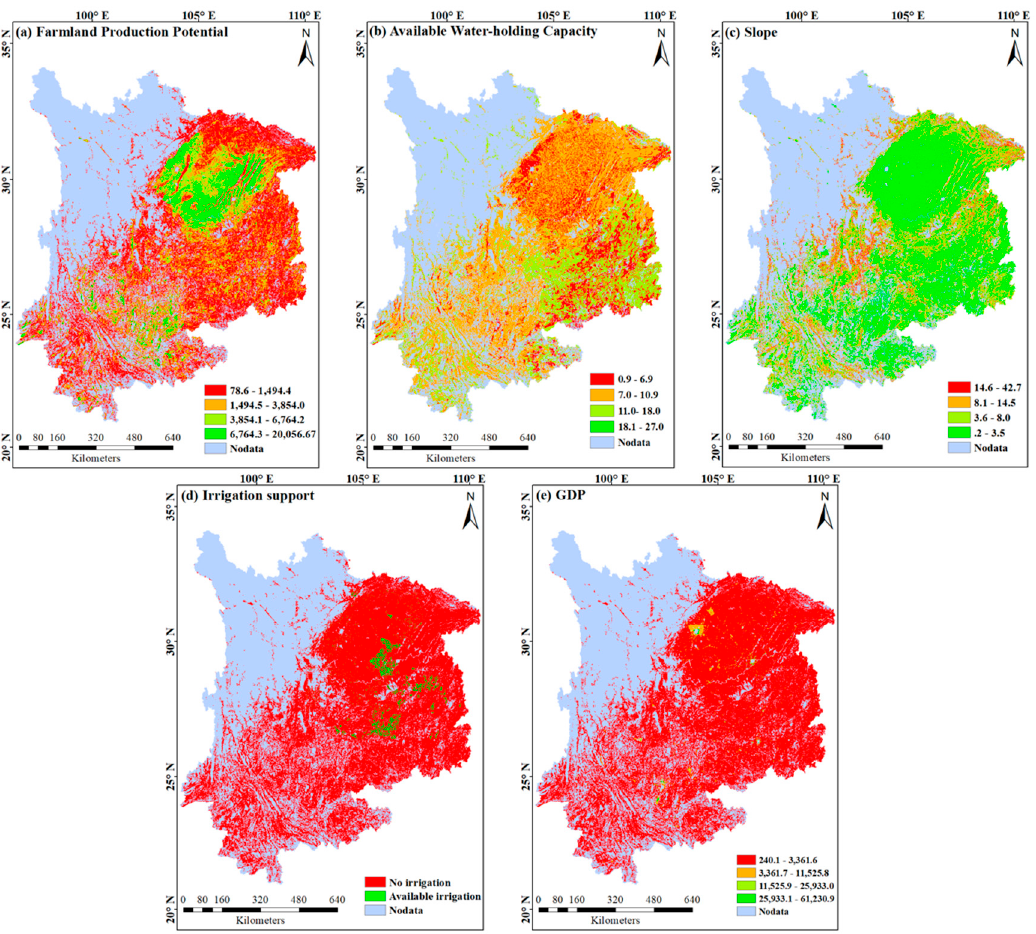
Figure 7. Grid-based maps of drought vulnerability indicators: ( a ) farmland production potential, ( b ) soil available water-holding capacity, ( c ) slope, ( d ) irrigation support, and ( e ) GDP.